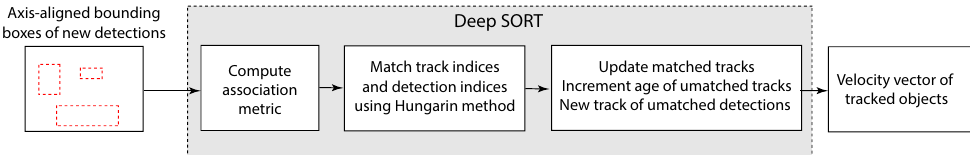
Figure 13. High-level pipeline illustration of how Deep SORT is used in the proposed solution. Deep SORT uses the Hungarian algorithm, to solve the data association